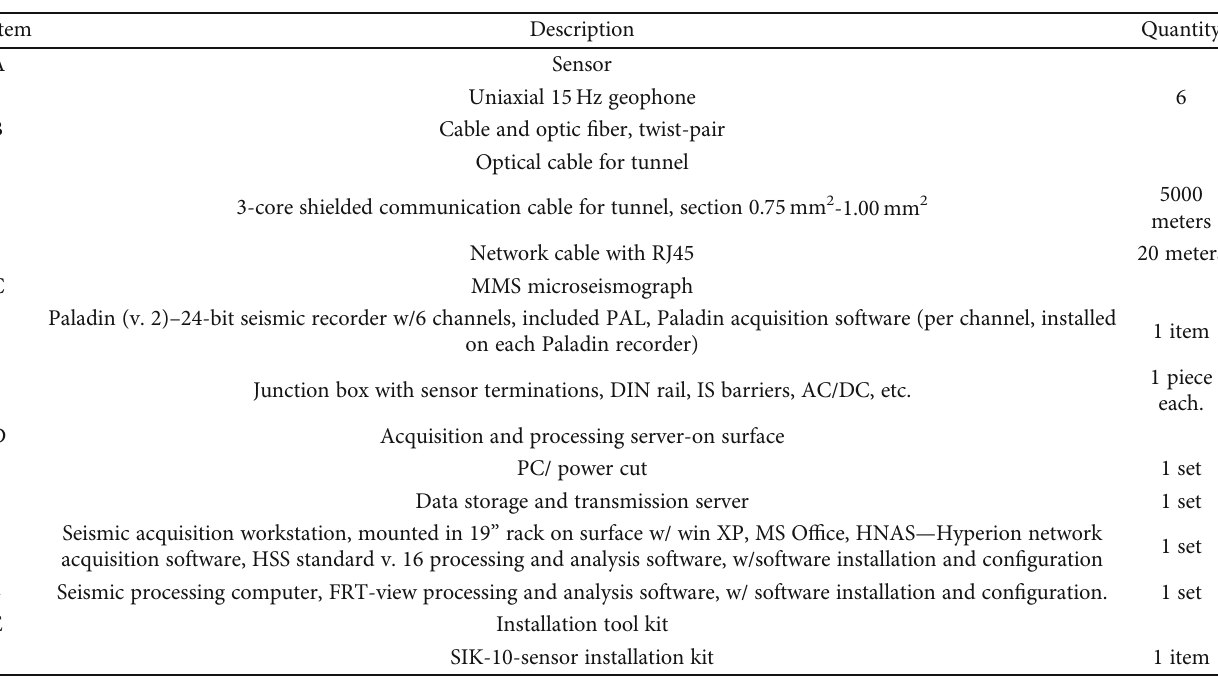
Figure 14: Frequency response curve of geophone type sensor. Table 1: System con fi guration